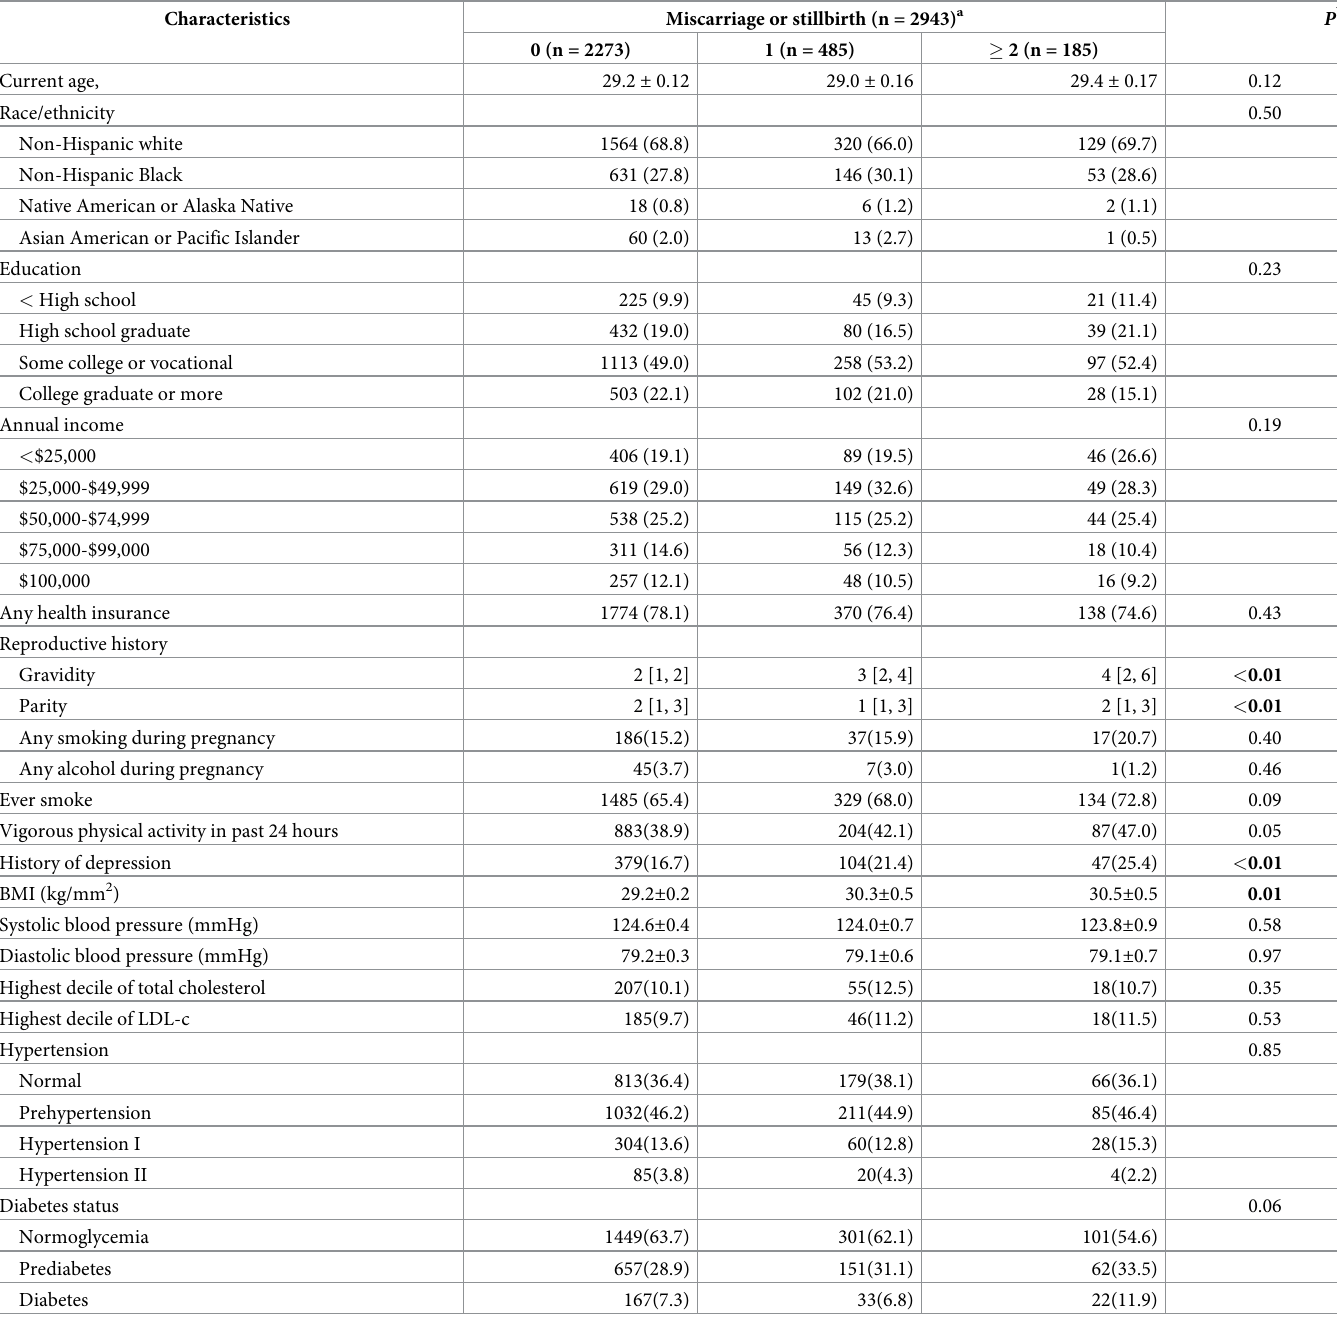
Table 1. Characteristics of women with at least one prior pregnancy in Add Health, Wave IV, 2007–2009 (weighted means ± SE, median [IQR] or percentages).